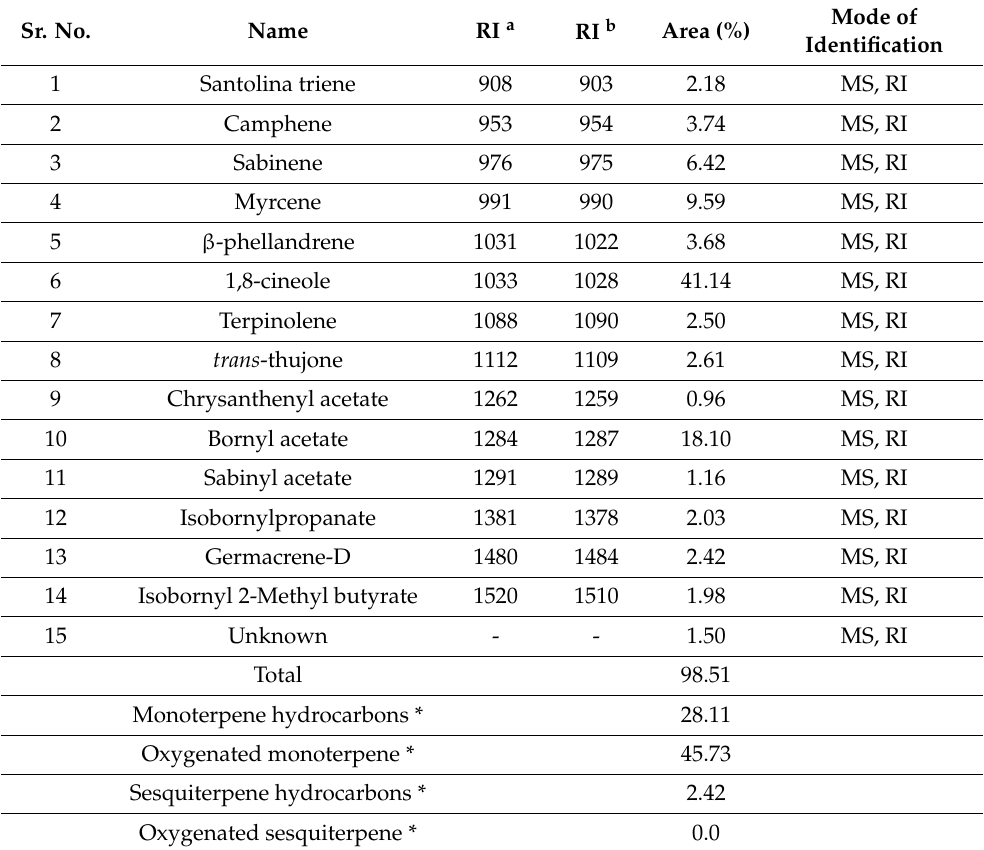
Table 1. Chemical composition of essential oil of A. maritima . Sr.